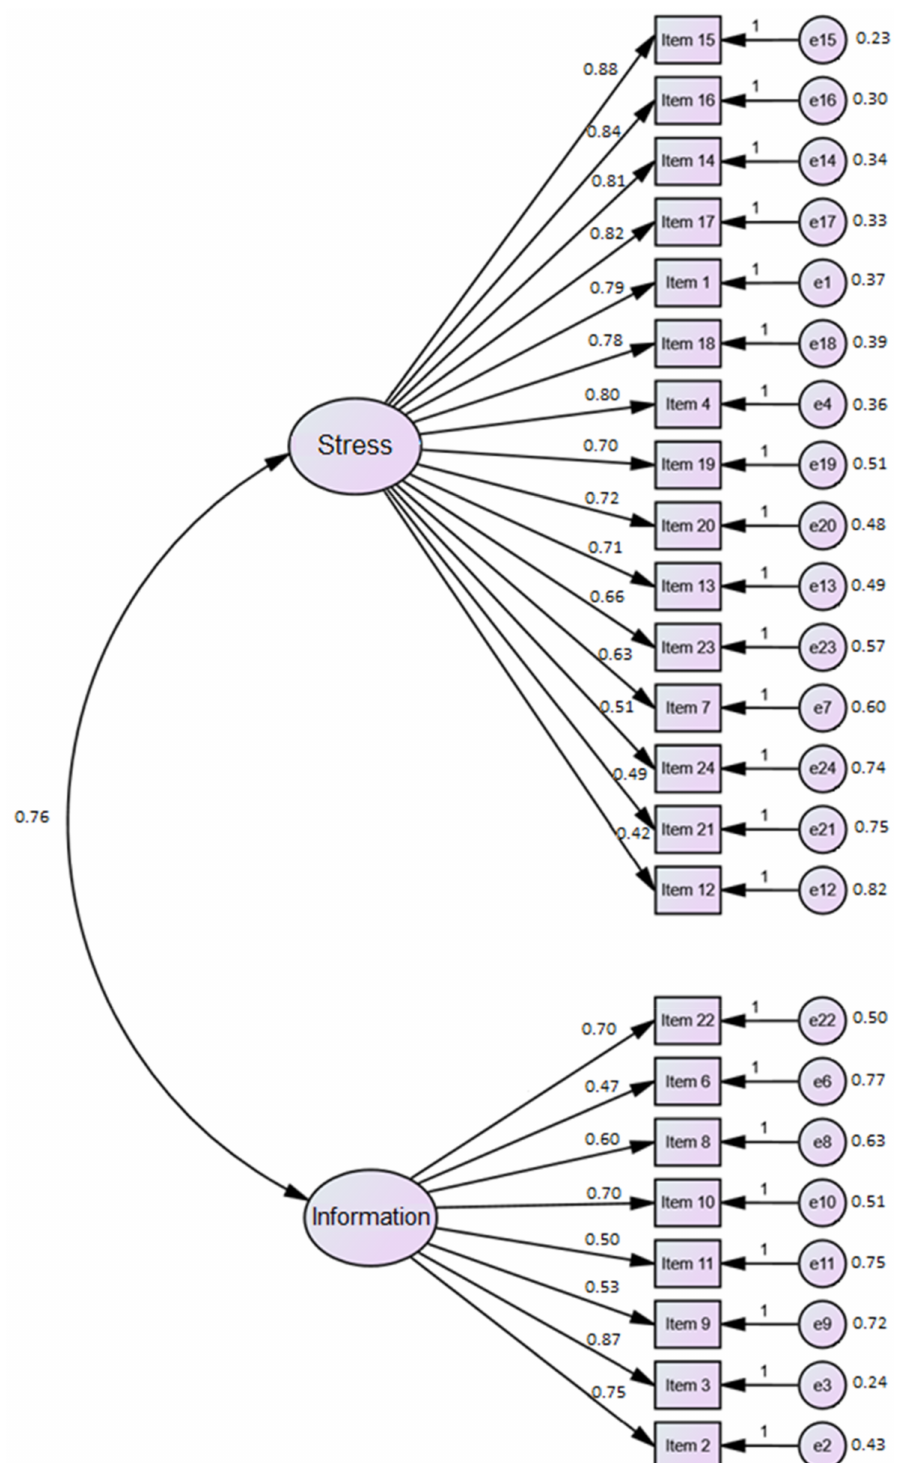
Figure 2. The standardized factor loadings and error variances for the hypothesized